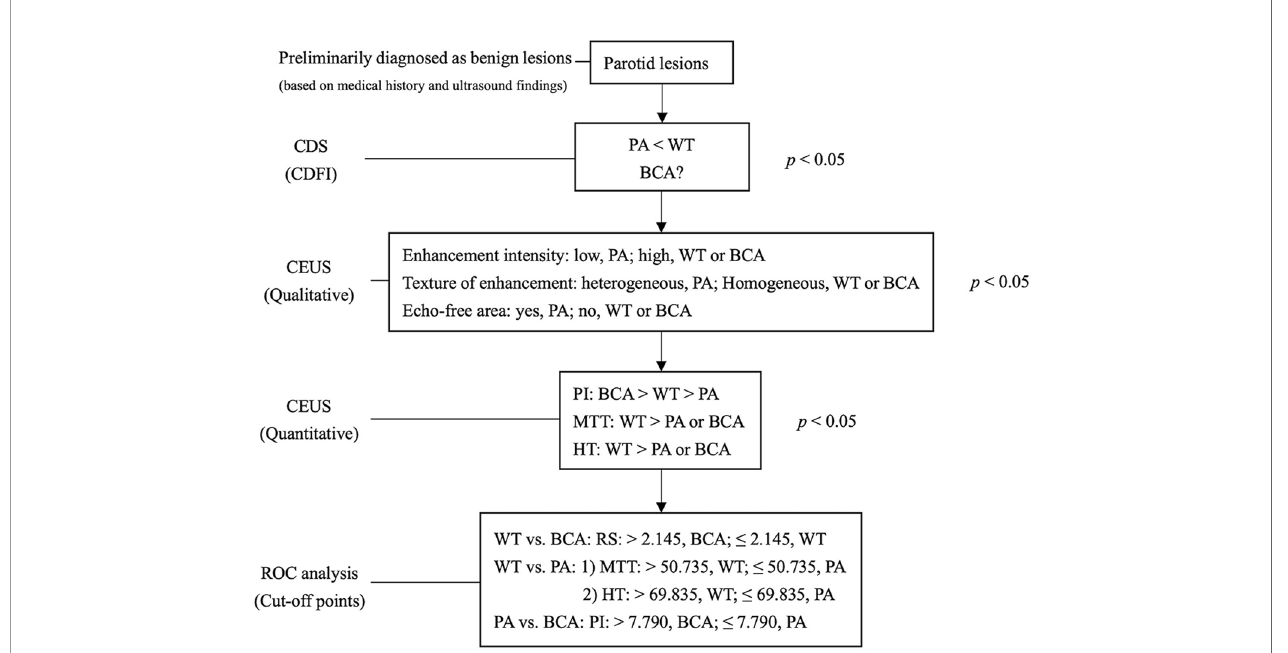
FIGURE 1 | Multimodal diagnostic pathway. The salivary lesions were preliminarily diagnosed as benign lesions based on medical history and B-mode ultrasound. The grade of CDFI distinguishes hyper- from hypo-vascularised tumor entities initially. Qualitative analysis of CEUS showed speci fi c features of lesions in the PA group and quantitative analysis of CEUS further differentiated the lesions in the BCA and WT groups. PA, pleomorphic adenoma; WT, Warthin tumor; BCA, basal cell adenoma; CEUS, contrast-enhanced ultrasound; CDFI, Color Doppler fl ow imaging; PI, peak intensity; MTT, mean transit time; HT, time from peak to one half; RS, rising slope of wash in curve; P < 0.050 was considered to be statistically signi fi cant. The optimal cutoff points calculated by ROC curve analysis are for diagnostic reference